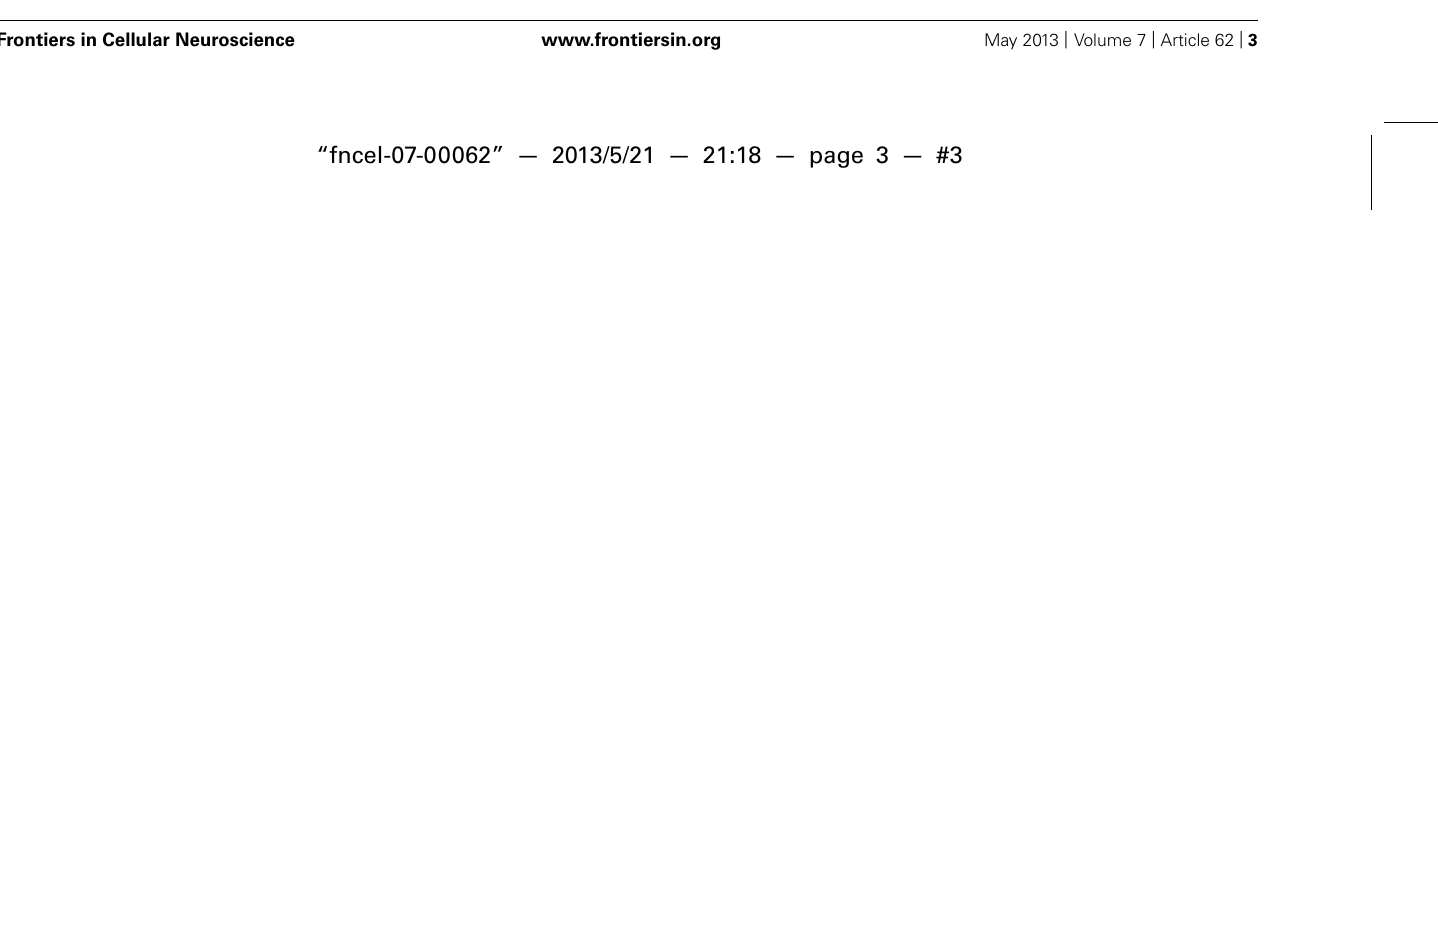
FIGURE 1 | Rho GTPase activation increases spine density and dendrite branching in hippocampal CA1 pyramidal neurons. (A,D) Photomicrographs (scale bar 100 μ m); (B,E) Neurolucida tracings; (C,F) detail of apical dendrite (scale bar 2 μ m) of representative Golgi stained neurons in hippocampal CA1 of C57BL/6J mice treated 10 days before